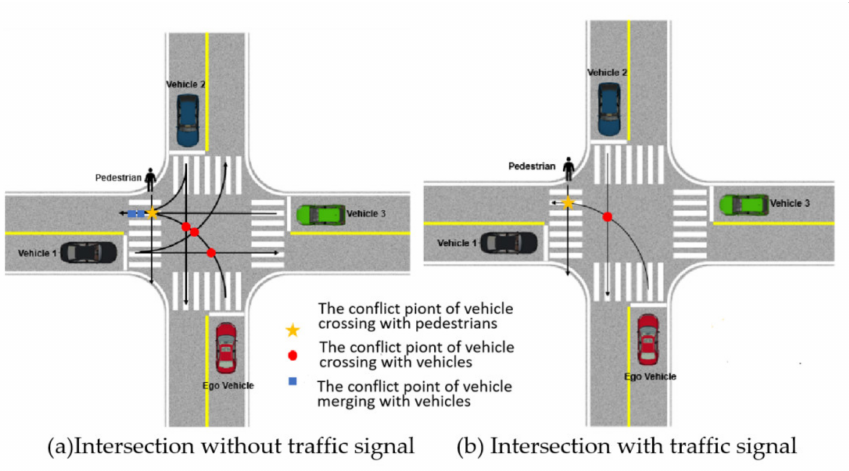
Figure 4. The conflict points formed in the left turn process of self-driving vehicles at intersections. At the intersection without traffic signal, the potential fields generated by vehicle 1, vehicle 2, vehicle 3 and pedestrians all should be taken into account when calculating the environment complexity of the autonomous vehicle, the potential field of the environmental elements is shown in Figure 5.